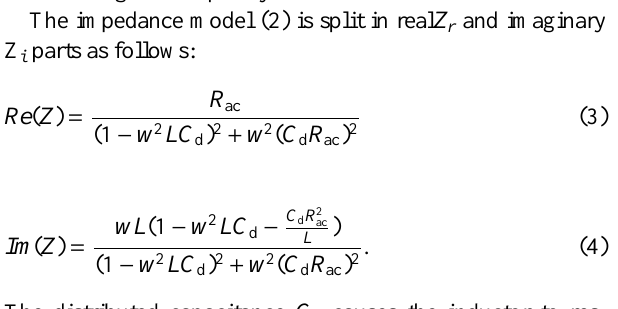
with the angular frequency w = 2 π f